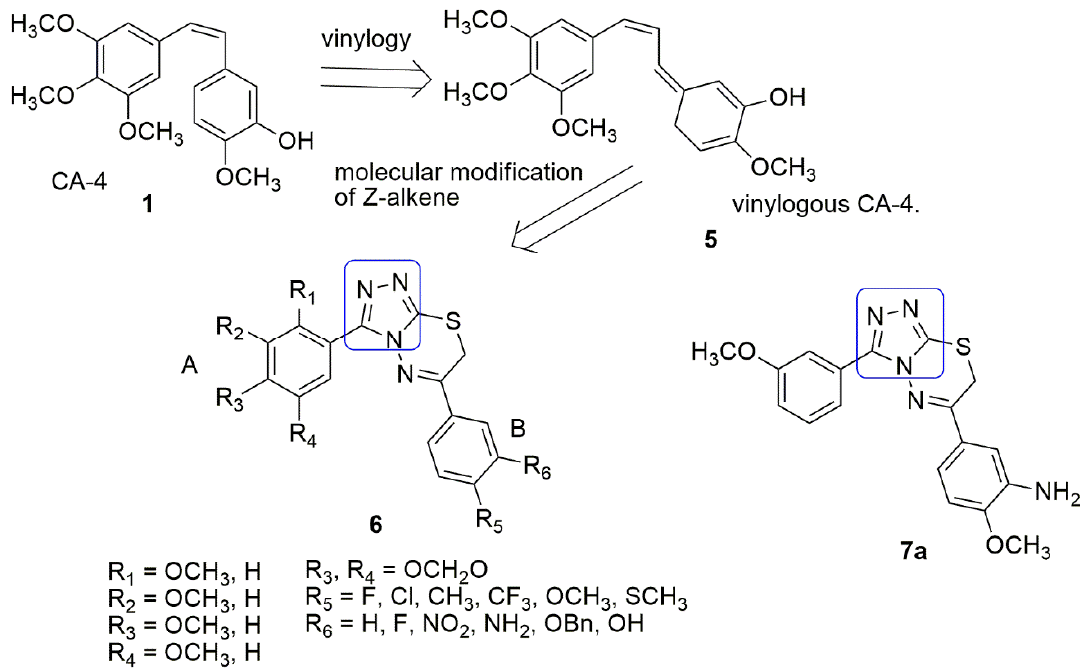
Figure 4. Chemical structures of triazole–thiadizine hybrids that inhibit tubulin polymerization. Piperazine has been reported as a potent compound that obstructs mitosis, induces cell apoptosis, binds to the colchicine site, and inhibits the tubulin [19,20]. Meanwhile, sulfonamide compounds are antibacterial, anticancer, antithyroid, antidiabetic, antiviral, and antihypertensive agents. In the published work of Manasa et al. [21], 1,2,3-triazole, sulfonamide, and piperazine moieties 9 were reported to be synthesized and evaluated for their in vitro cytotoxic potential against a selected panel of human cancer cell lines. These include BT-474 (breast), HeLa (cervical), MCF-7 (breast), NCI-H460 (non-small cell lung cancer), and HaCaT (human epidermal keratinocytes) using the MTT assay. The substitution of the R-group with meta -phenoxy and R 1 with 4-Br showed improved cytotoxicity on the BT-474 cancer cell line ( IC 50 value of 0.99 ± 0.01 µ M) among the synthesized compounds (see Figure 5). The tubulin targeting ability of 5 was moderate. It could also effectively inhibit tubulin polymerization with increased concentration and induce a blockade of the sub-G1 and G2/M phase in the cell cycle, including morphological changes and cell pro- liferation inhibition through the induction of apoptosis. The molecular modeling studies show the interaction of compound 9a with tubulin via the colchicine binding site. The sulfonyl group has been shown to establish a strong hydrogen bond interaction with Ser178, and the triazole moiety forms two hydrogen bond interactions with binding site residues (Ala250 and Lys254). It shares hydrophobic contacts with residues of α / β -tubulin and fits well into the binding site interphase of α / β -tubulin (see Figure 5).